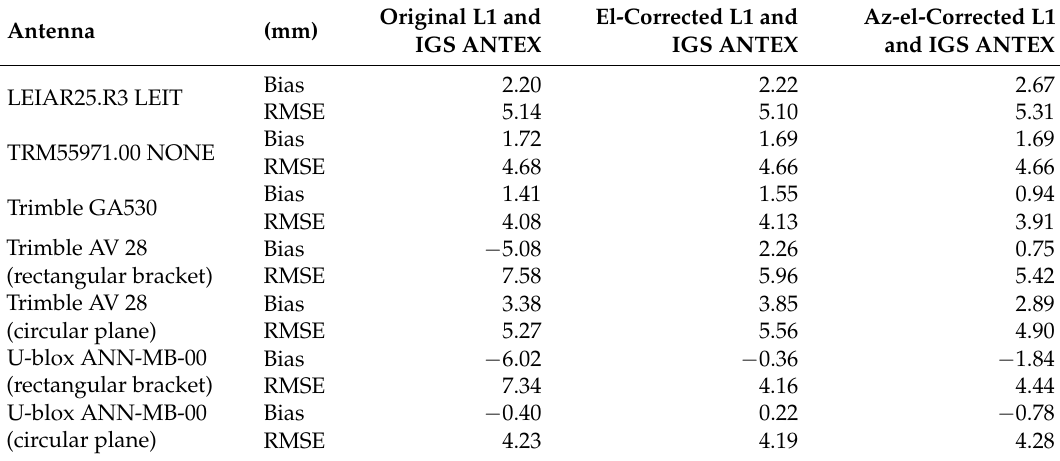
Table 7. ZTD PPP results using original L1 data, elevation-corrected L1 data and